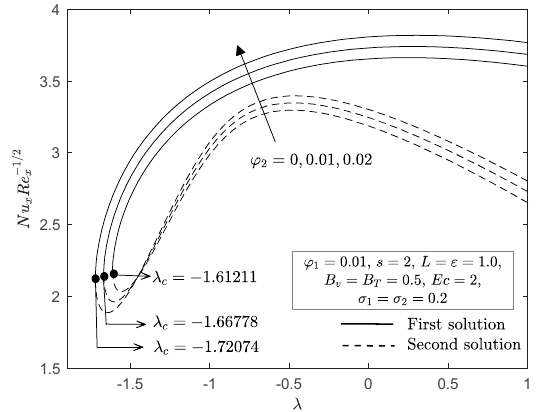
Figure 5. with λ for various Figure 5. Nu x Re − 1/2 x with λ for various ϕ 2 .